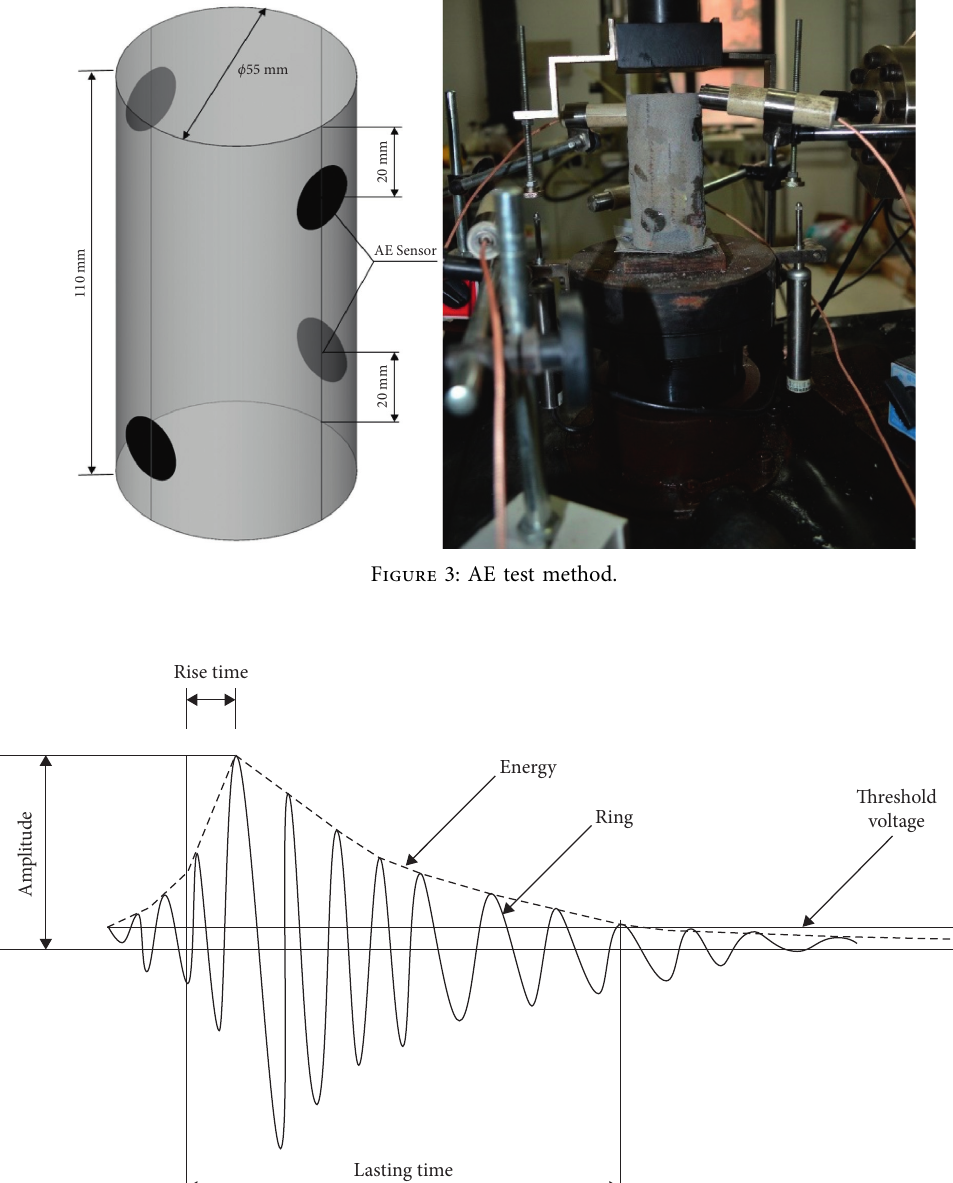
Figure 4: The diagram of acoustic emission characteristic